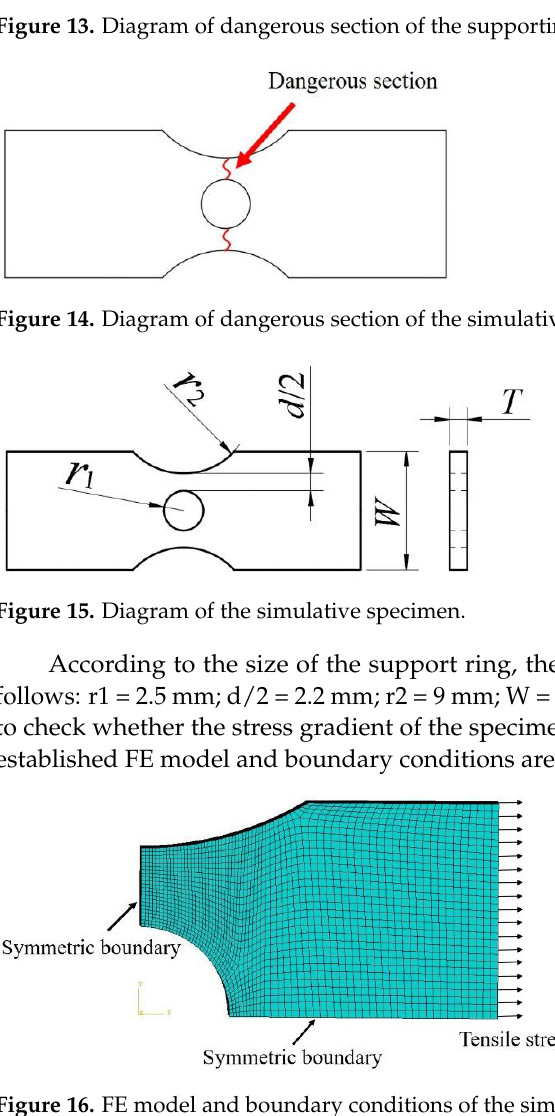
Figure 16. FE model and boundary conditions of the simulative specimen.